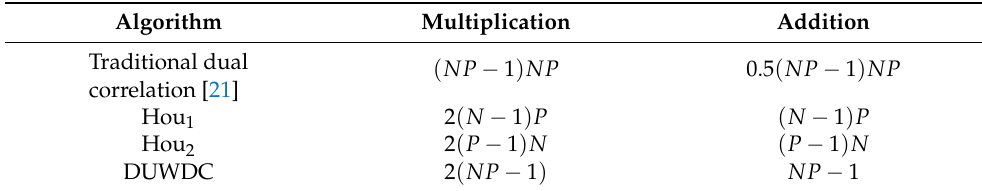
Table 1. Complexity comparison of four detection algorithms.